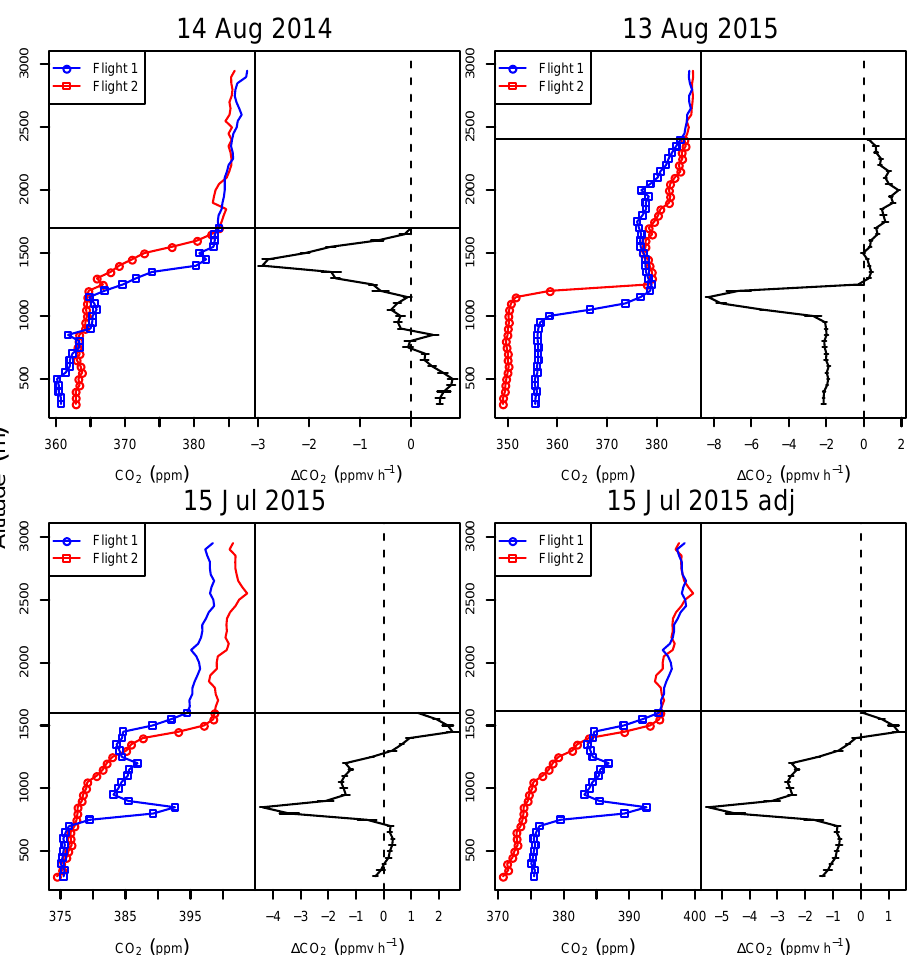
Figure 4. The left portion of each panel shows the mixing ratio of carbon dioxide to an altitude of 3000m for the two launches (blue for the first launch, red for the second). The differences in carbon dioxide mixing ratio contribute to the calculated NEE and also help to visualize mixed-layer processes ( (cid:49) CO 2 ). The error bars for (cid:49) CO 2 are 1 standard error. The top-left panel from 14 August 2014 shows a flight that has little change in the mixed-layer carbon dioxide mixing ratio, but the increase in boundary layer height leads to negative values for (cid:49) CO 2 and hence a negative NEE. The top-right panel from 13 August 2015 shows a flight that has both a decrease in mixed-layer carbon dioxide mixing ratio and an increase in the boundary layer height, contributing to a negative NEE. However, there is also a positive (cid:49) CO 2 above the mixed layer that is not straightforward to interpret (see text). The bottom panels from 15 July 2015 demonstrate a flight that was corrected due to instrumentation error. The original data (bottom-left) had carbon dioxide mixing ratios that differed consistently in the free troposphere. This was corrected to match free-tropospheric carbon dioxide mixing ratios between flights and produced reasonable profiles of carbon dioxide mixing ratio and (cid:49) CO 2 in the boundary layer